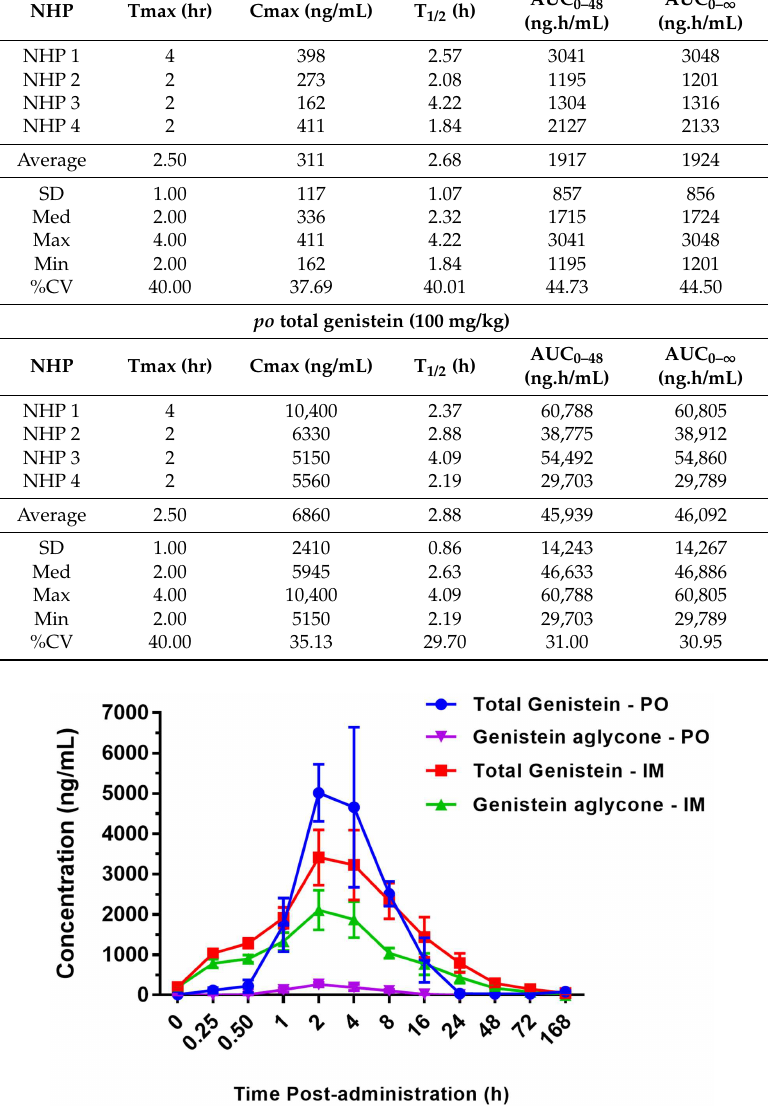
Figure 1. Pharmacokinetic analysis of BIO 300: Oral ( po ) vs intramuscular ( im ) administration. BIO 300 (50 mg/kg, im and 100 mg/kg, po ) was administered to four nonhuman primates (NHPs). Blood samples were collected at various time points following BIO 300 administration. Total (glucuronidated genistein and genistein aglycone) and genistein aglycone concentrations were determined using a validated bioanalytical